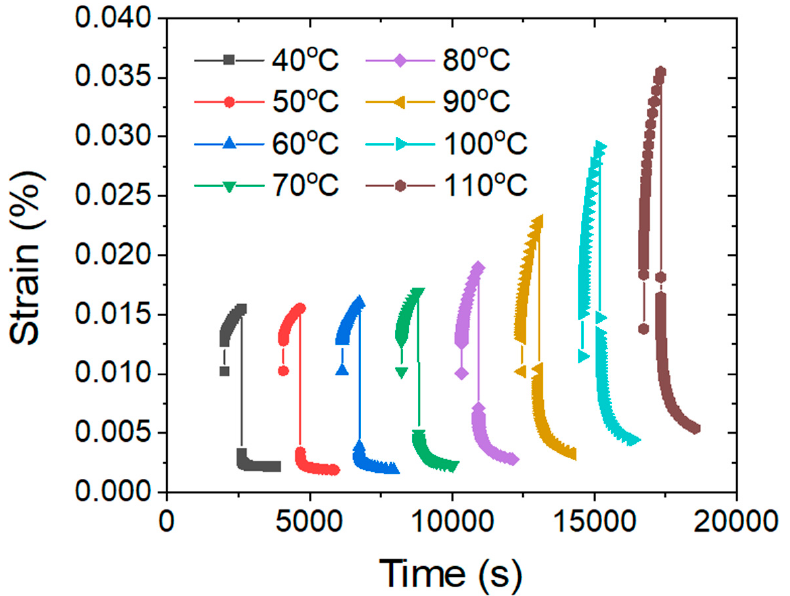
Figure 7. Creep and creep recovery curves at test temperatures ranging from 40 to 110 ° C.